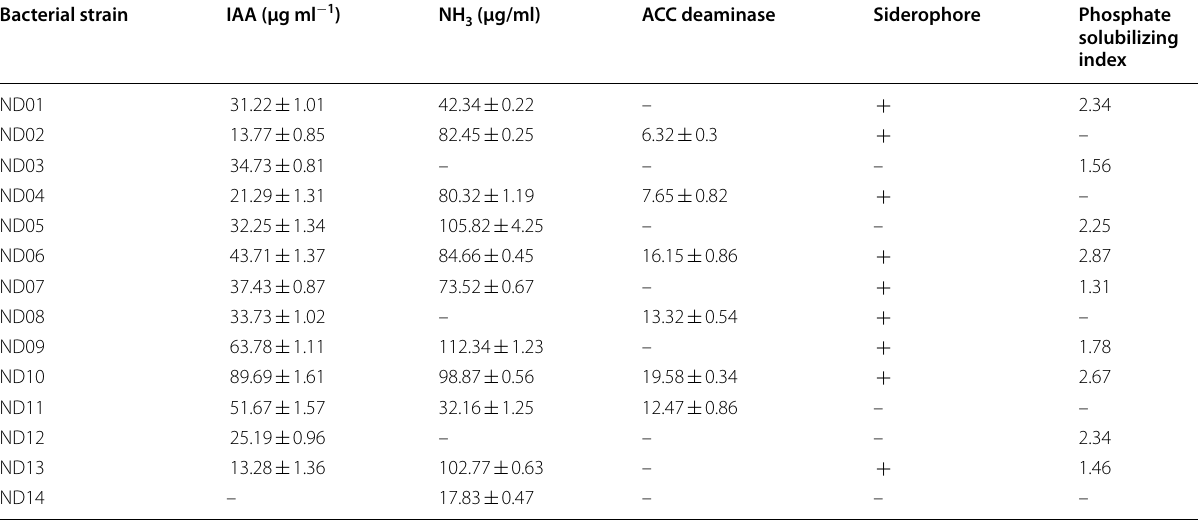
Presence of trait; absence of trait; The data represent the mean + − spectrophotometrically at 590 nm and expressed as µmol mg − 1 protein h −